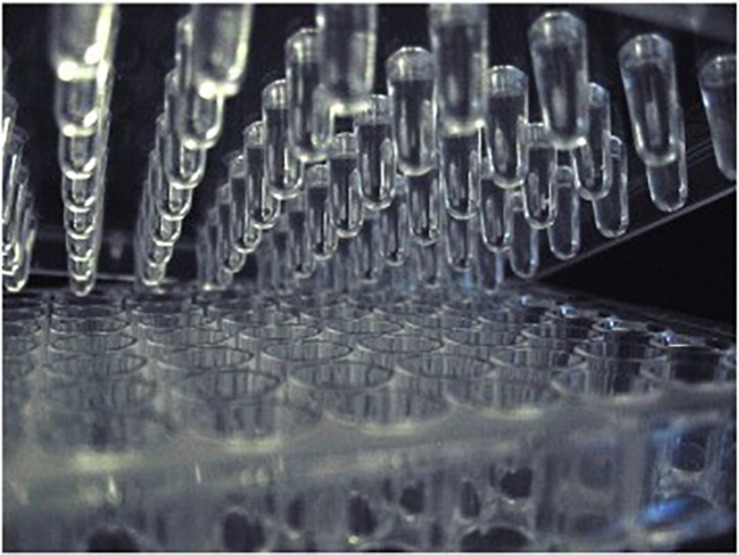
Regular MBEC with 96-well plate. Photography adapted from Parker et al. (2014).